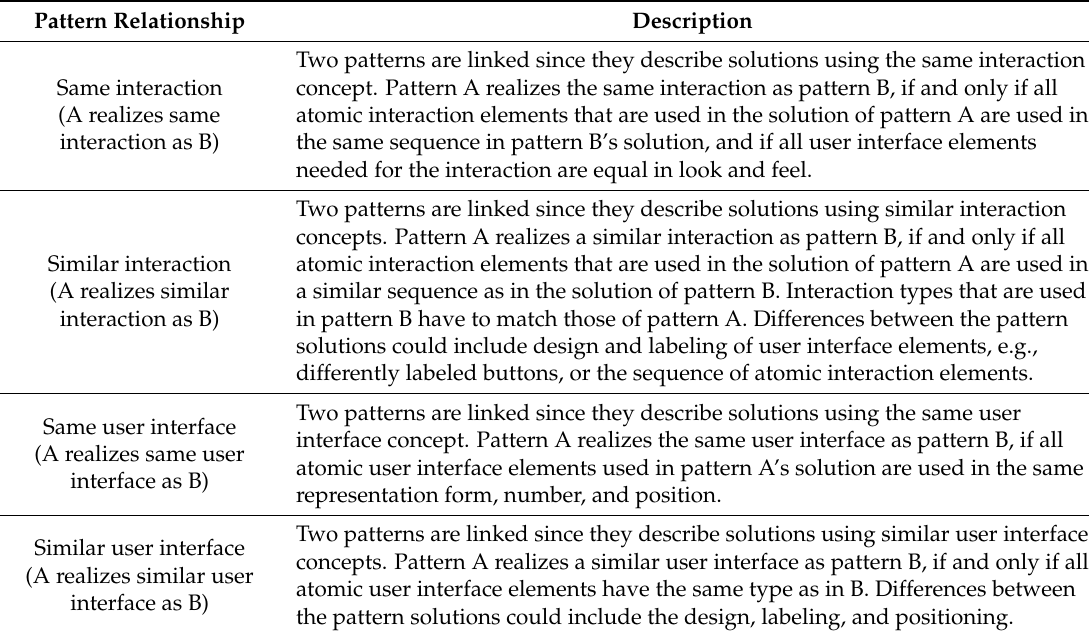
Table 5. Pattern relationships and